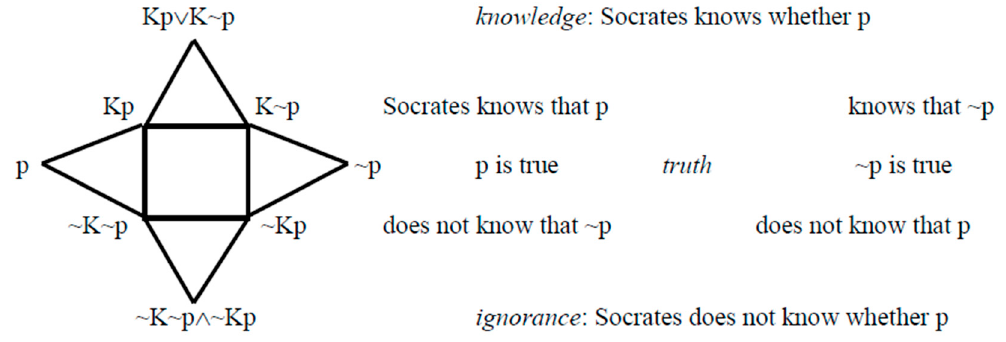
Figure 9. The octagon of knowledge and ignorance.